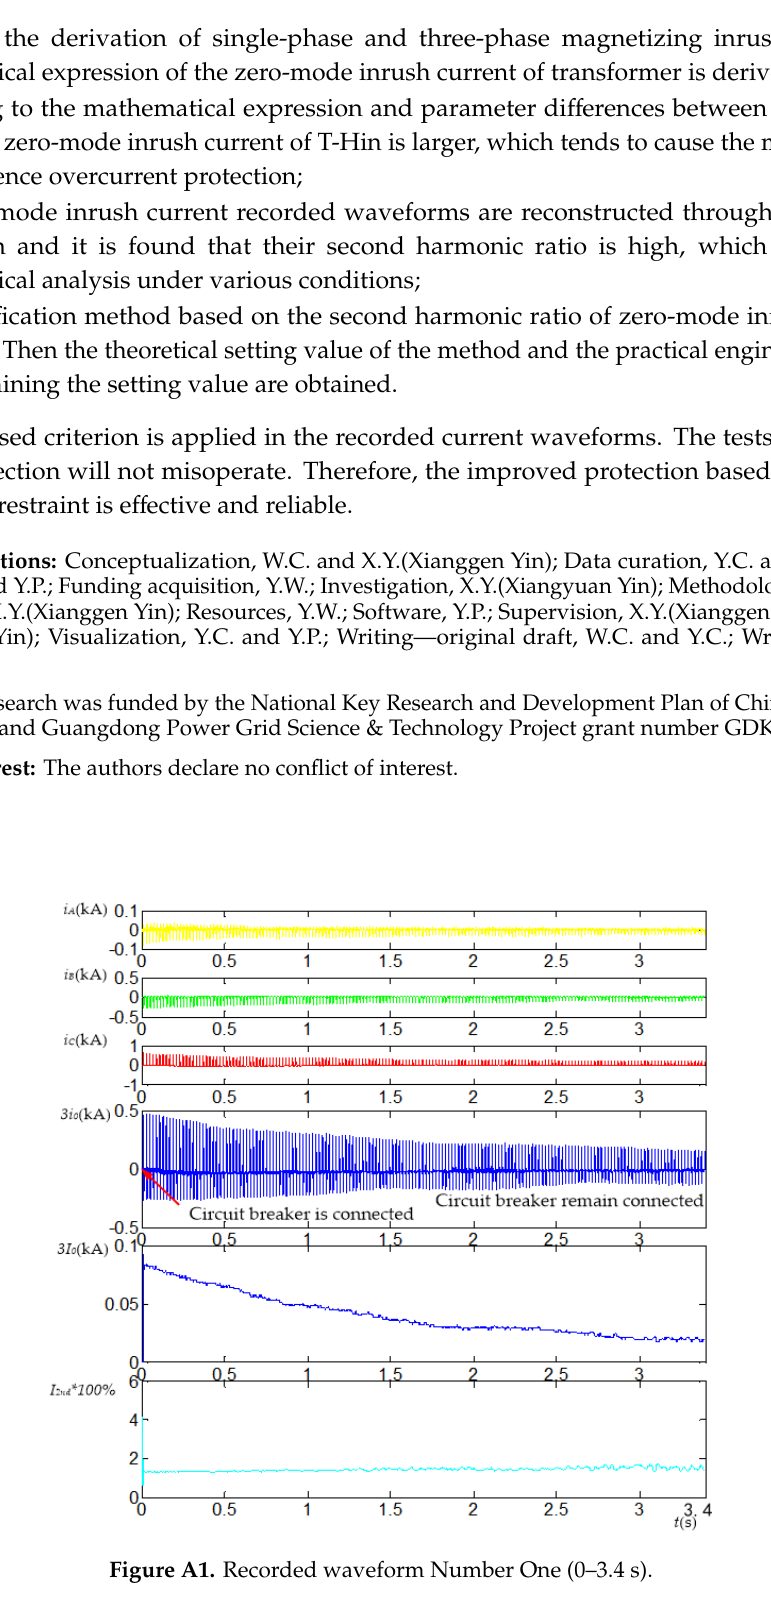
Figure A2. Recorded waveform No. 1 (0 – 0.6 s).